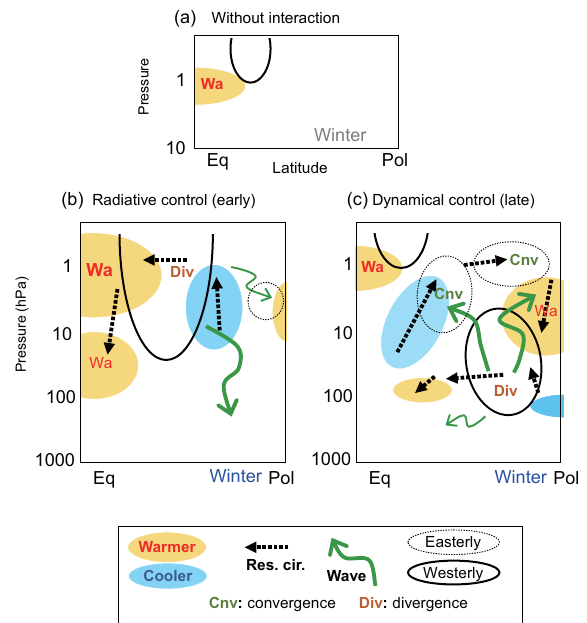
Figure 17. Schematic presentation of the solar influence on the winter stratosphere. (a) Hypothetical response to solar UV heating without interaction with planetary waves. (b) Early winter when so- lar radiative forcing dominates, and (c) late winter when dynam- ical forcing from the troposphere becomes more important. Solid (dashed) contours display anomalous westerly (easterly) winds. Yellow (blue) filled contours represent anomalous warming (cool- ing). Solid green (dashed black) arrows indicate anomalous prop- agation of planetary waves (mean residual circulation). “Div” and “Cnv” indicate anomalous divergence and convergence of the E–P flux, respectively. See text for